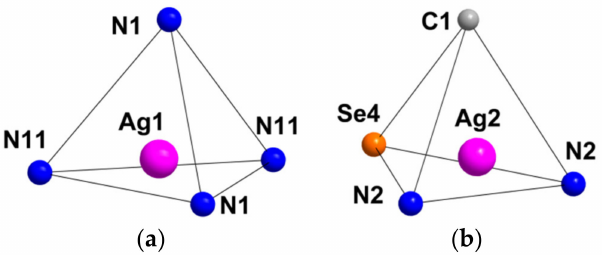
Figure 12. Coordination polyhedral of Ag1 ( a ) and Ag2 ( b ) atoms in the structure of 4 .